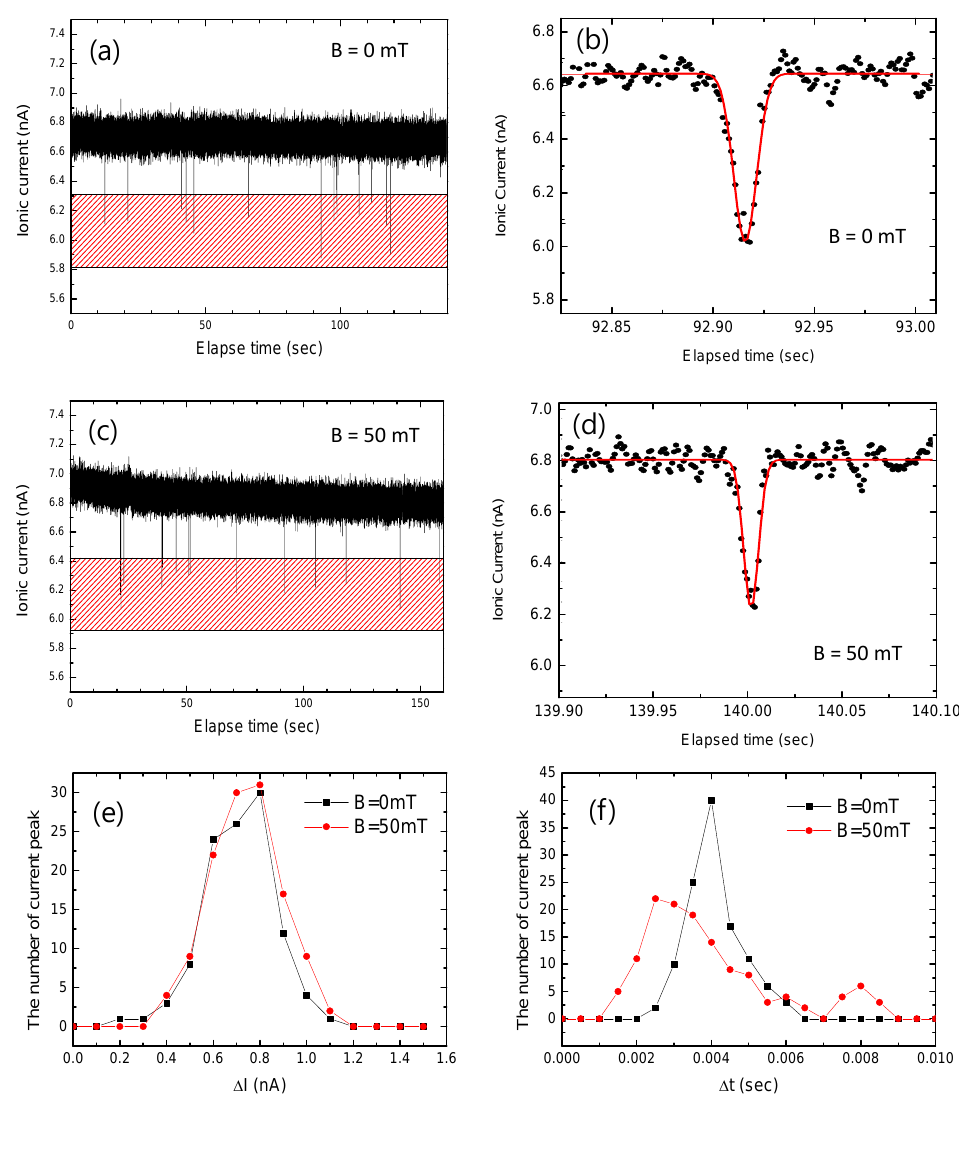
Figure 4. Time-dependent ionic current of charged magnetic NPs in the absence of magnetic field, ( a ) a global view and ( b ) a magnified view, and in the presence of a magnetic field, ( c ) a global view and ( d ) a magnified view. ( e ) Distribution of the ionic current blockade amplitude ( Δ I) for 300 sec. ( f ) Distribution of the ionic current blockade dwell time ( Δ